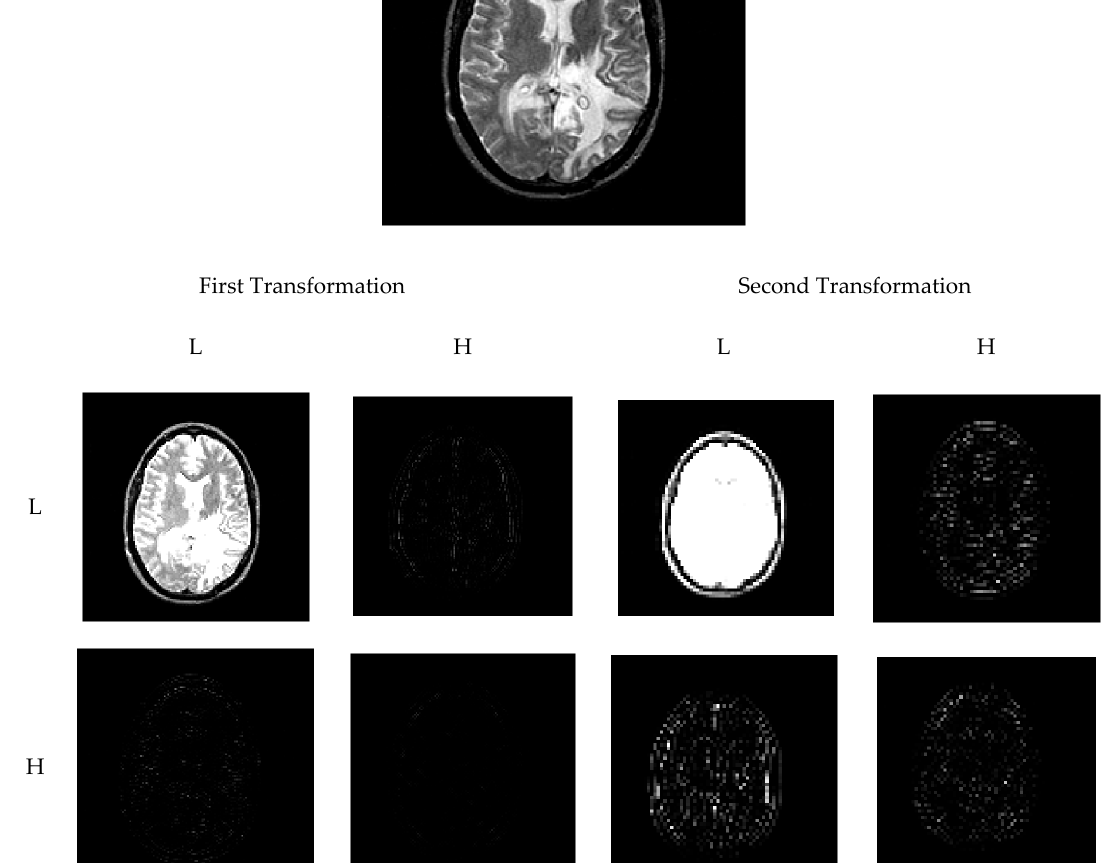
Figure 3. The sub-bands of the wavelet transformation.